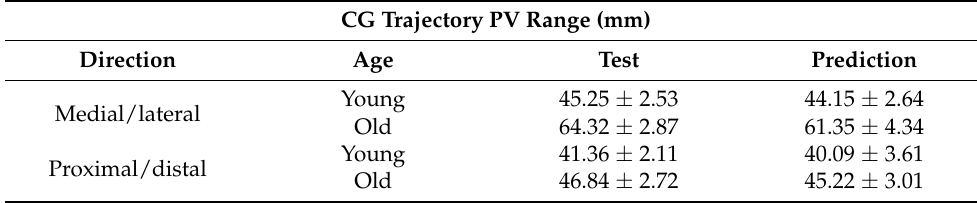
Table 3. Average measured and predicted CG trajectory PV ranges for age